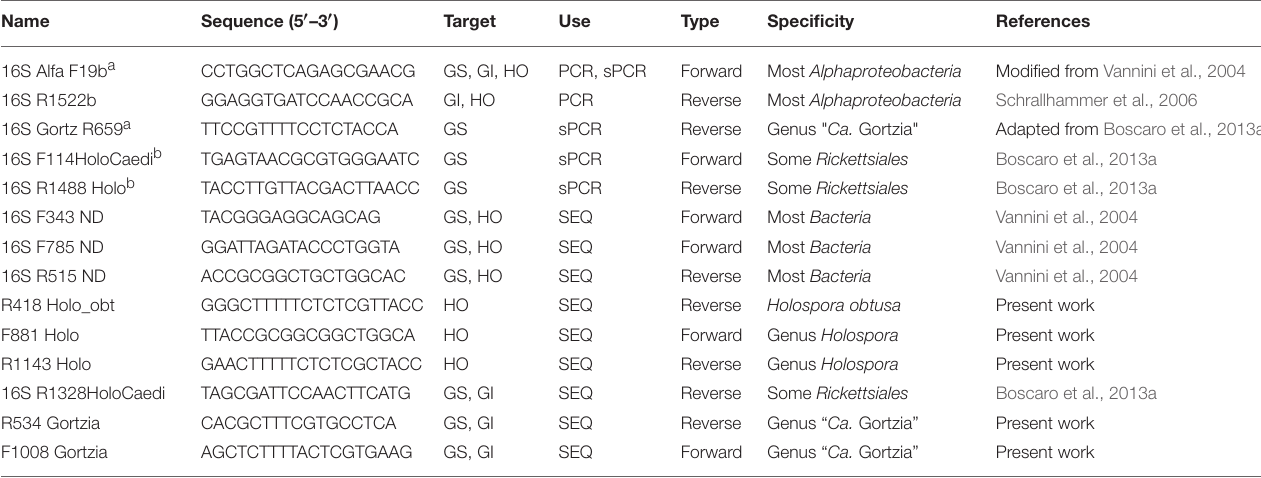
TABLE 1 | List of primers used for 16S rRNA encoding gene sequencing of Holospora -like bacteria from Paramecium